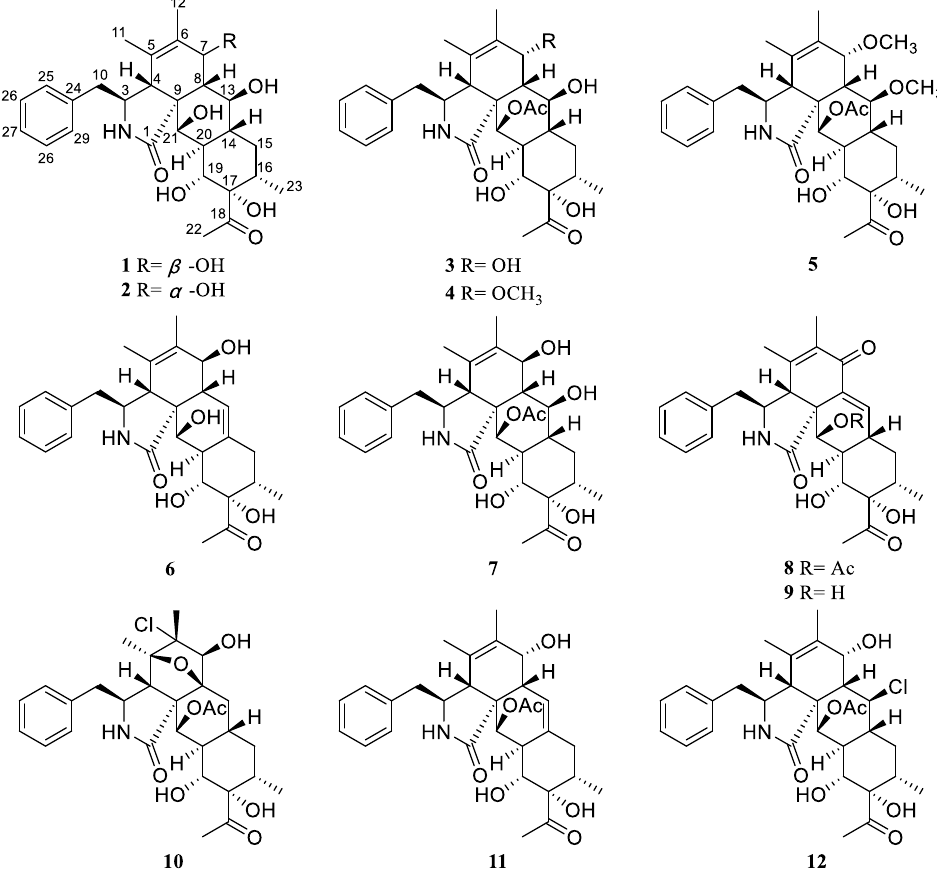
Figure 1. Chemical structures of compounds 1 – 12.